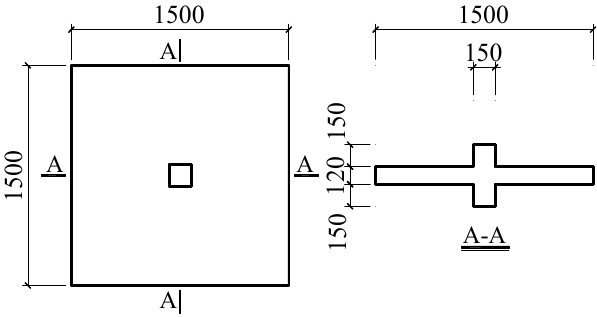
Figure 4. Specimen SB1 (dimensions in mm). Table 2. Material Properties of Specimen SB1.